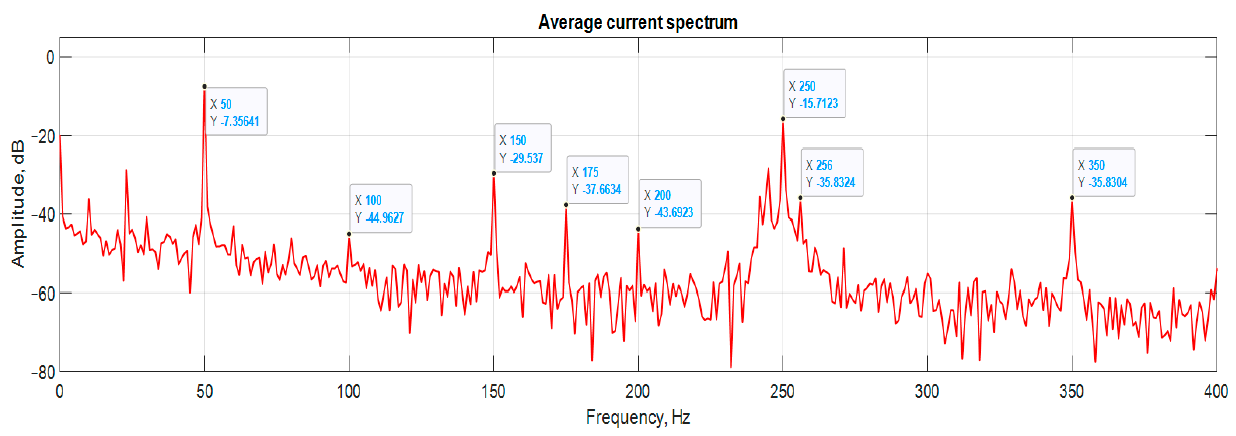
Figure 15. The spectrum at medium defect.